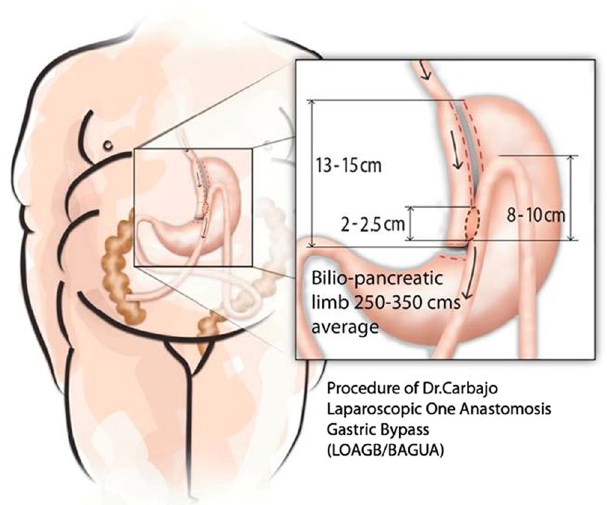
Figure 1. Graphic representation of the OAGB technique.